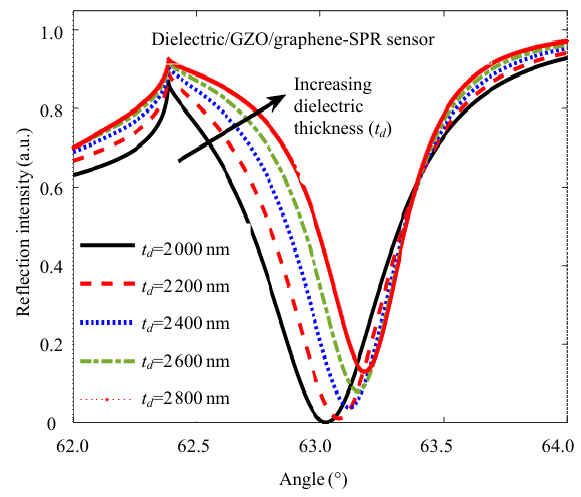
Fig. 4 Reflectance curve of the proposed SPR sensor for dielectric thickness variation from 2 000 nm to 2 800 nm (thicknesses used for graphene and GZO are 0.34 nm and 20 nm, respectively; RIs for the dielectric medium and sensing medium are n d = 1.34 and n s = 1.33, respectively).